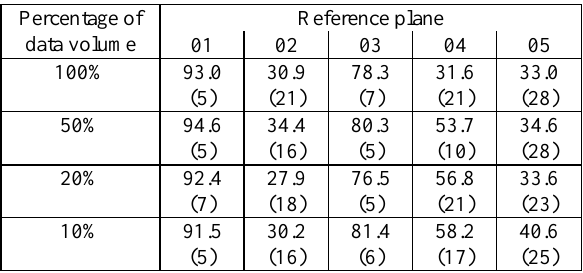
Table 2. Validity of planes for varying spatial resolutions in terms of congruency with the reference planes in %, number of